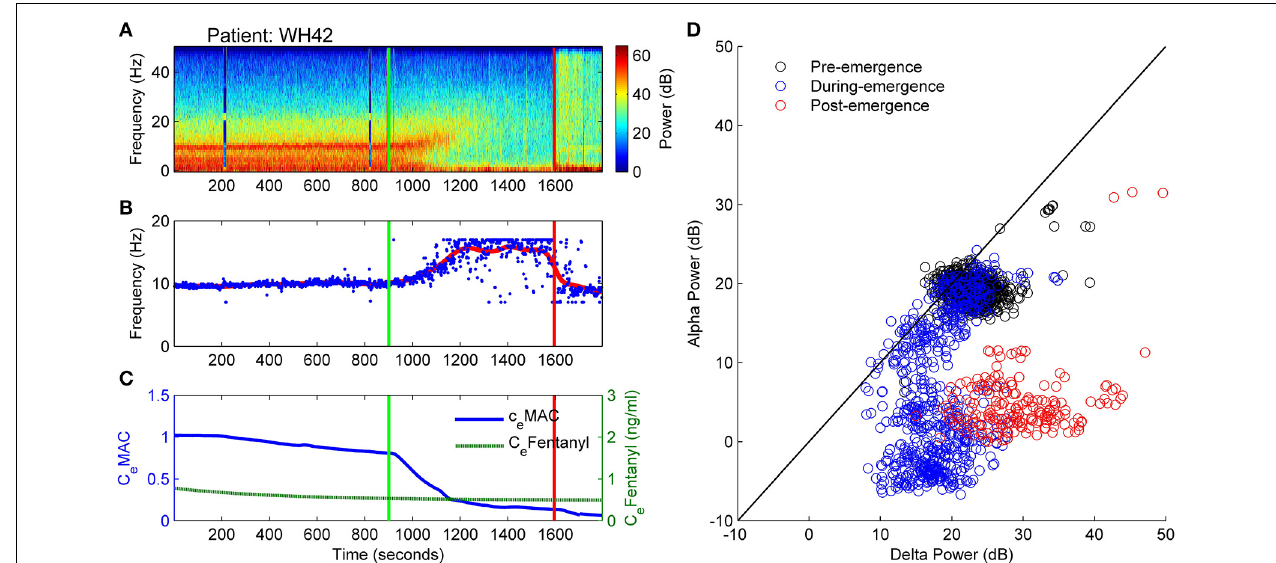
FIGURE 6 | Patient WH42. Archetypal emergence. (alpha frequency increase, alpha loss, persistent delta). (A) Spectrogram of the observation period. Start of emergence shown as a vertical green line at 900s, time of patient response as a vertical red line. (B) Frequency of maximal oscillatory alpha power. (C) Concentration of anesthetic gas (C e MAC),